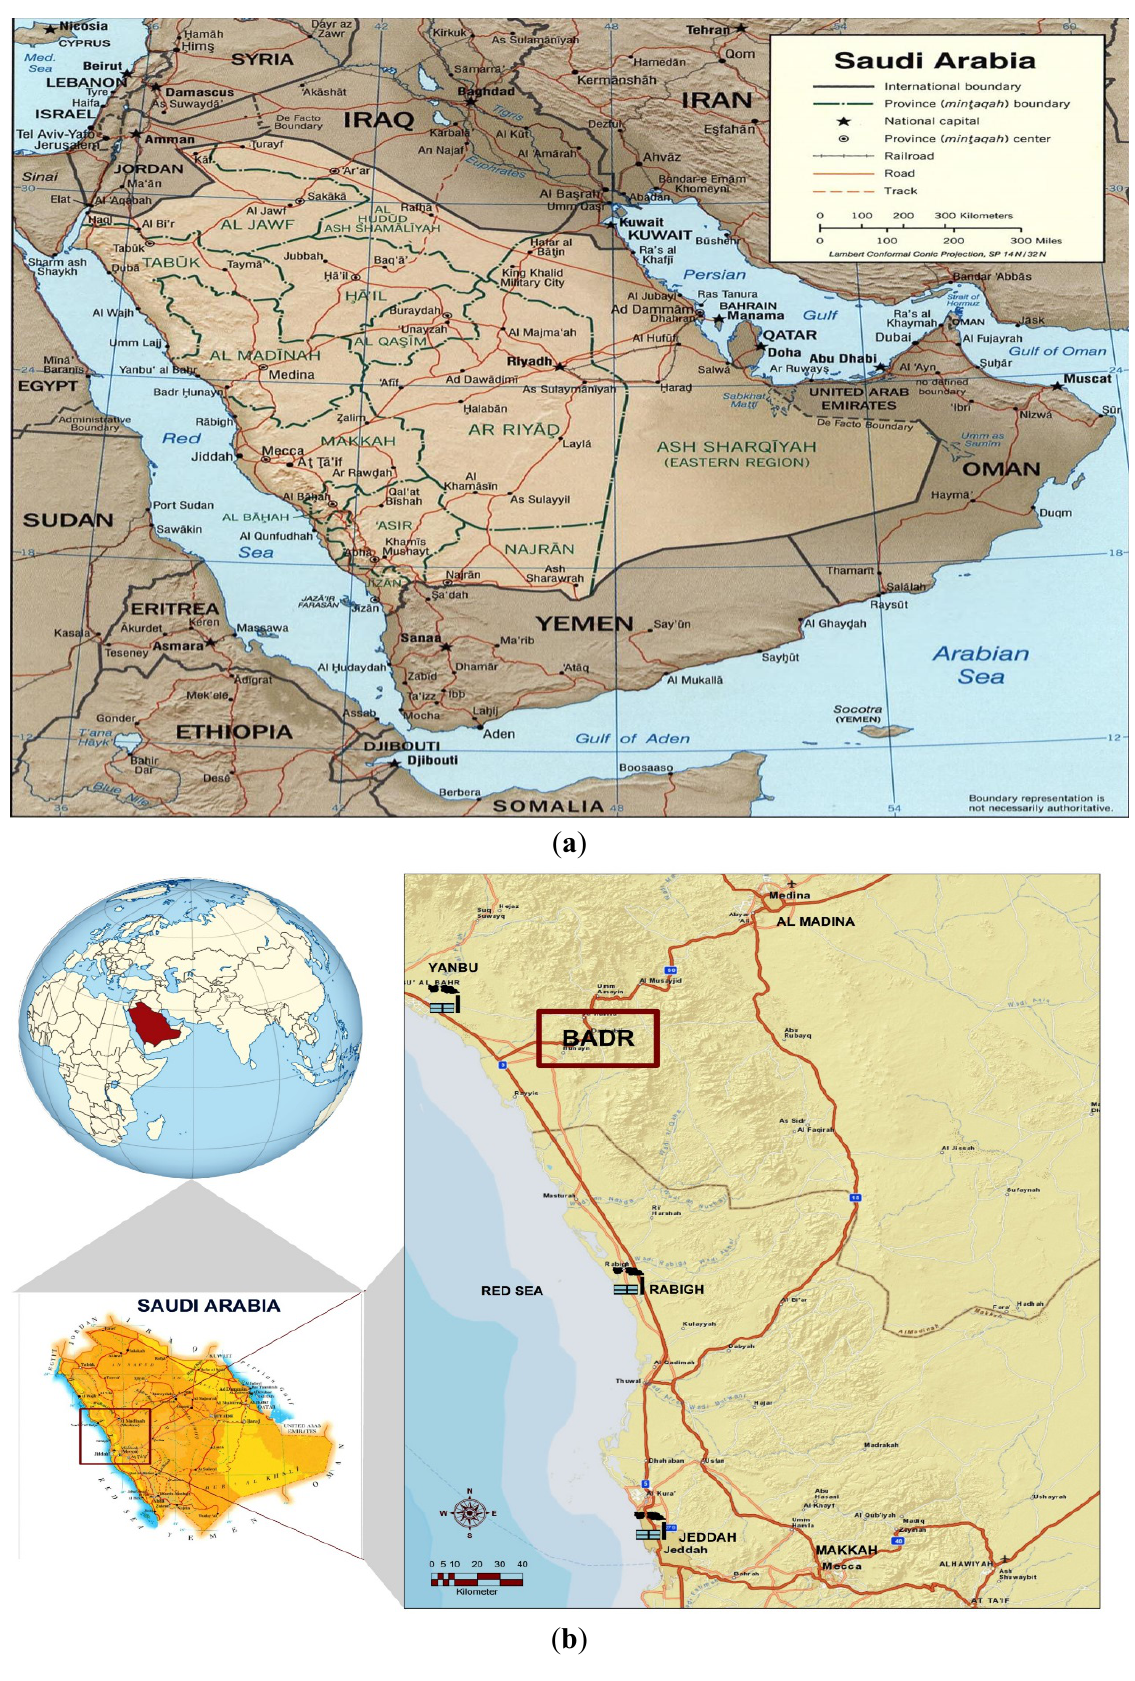
Figure 2. ( a ) Map of Saudi Arabia; ( b ) Map of western Saudi Arabia showing location of sampling site,